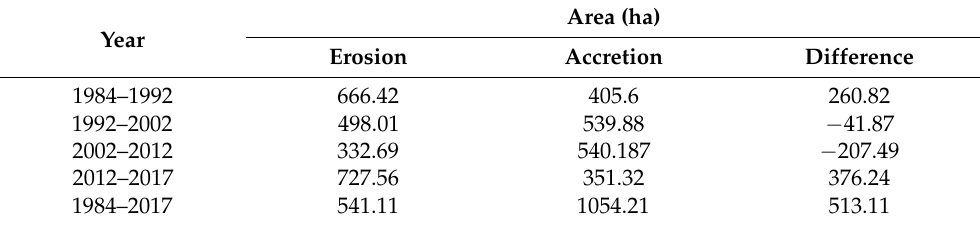
Table 2. Total amount of erosion, deposition, and their difference from